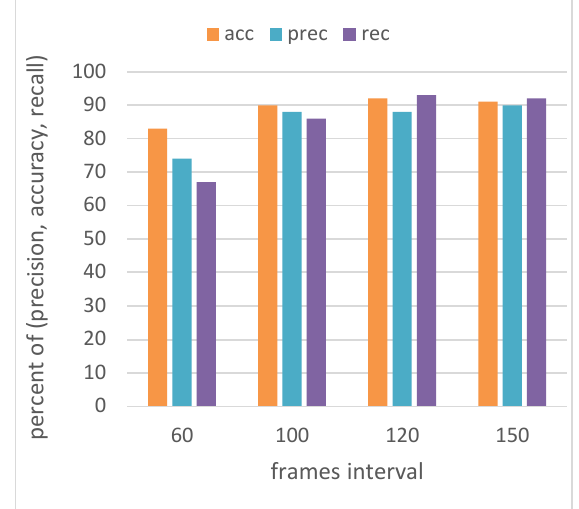
Figure 5. Accuracy, precision and recall for different frame accuracy when using 60 as frames interval accuracy when using 102 as frames interval accuracy when using 120 as frames interval accuracy when using 150 as frames interval